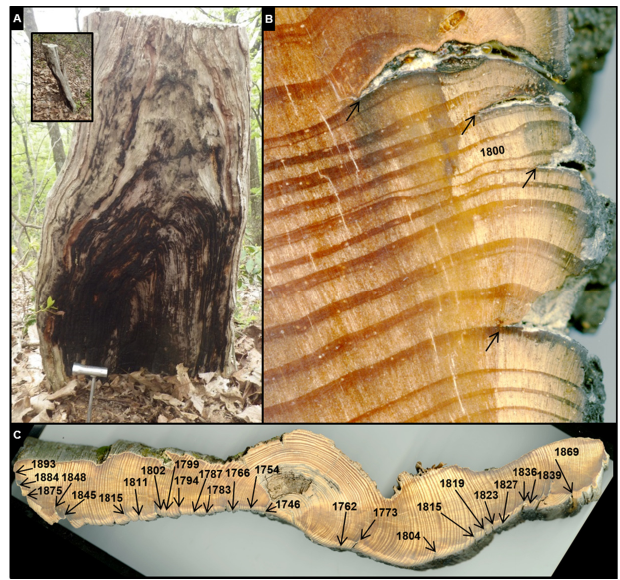
Figure 2. ( A ) Fire-scarred pitch pine ( Pinus rigida ) stump (sample no. 107032) with charcoal, inset shows side view. ( B , C ) Cross-sectional views of rings and fire scars from this sample, arrows denote fire-scar years. This tree had 27 fire scars during the time period of 1734–1898, with most scars occurring in the dormant season tree-ring